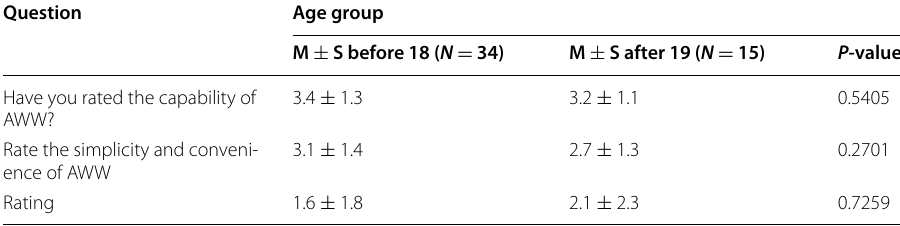
Table 10 Comparison of quantitative variables by age group